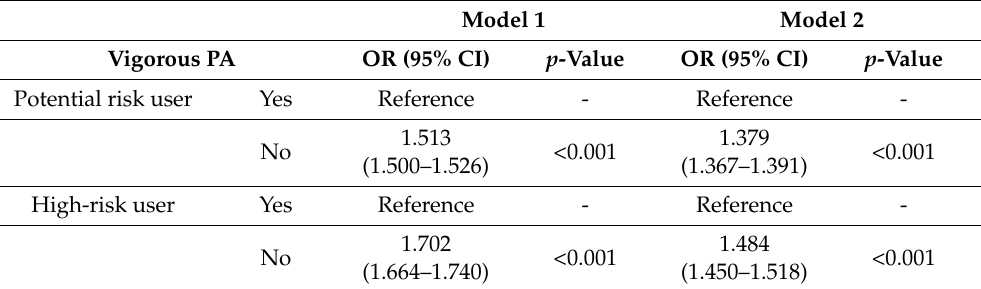
Table 4. Logistic regression analysis on level of smartphone addiction based on vigorous